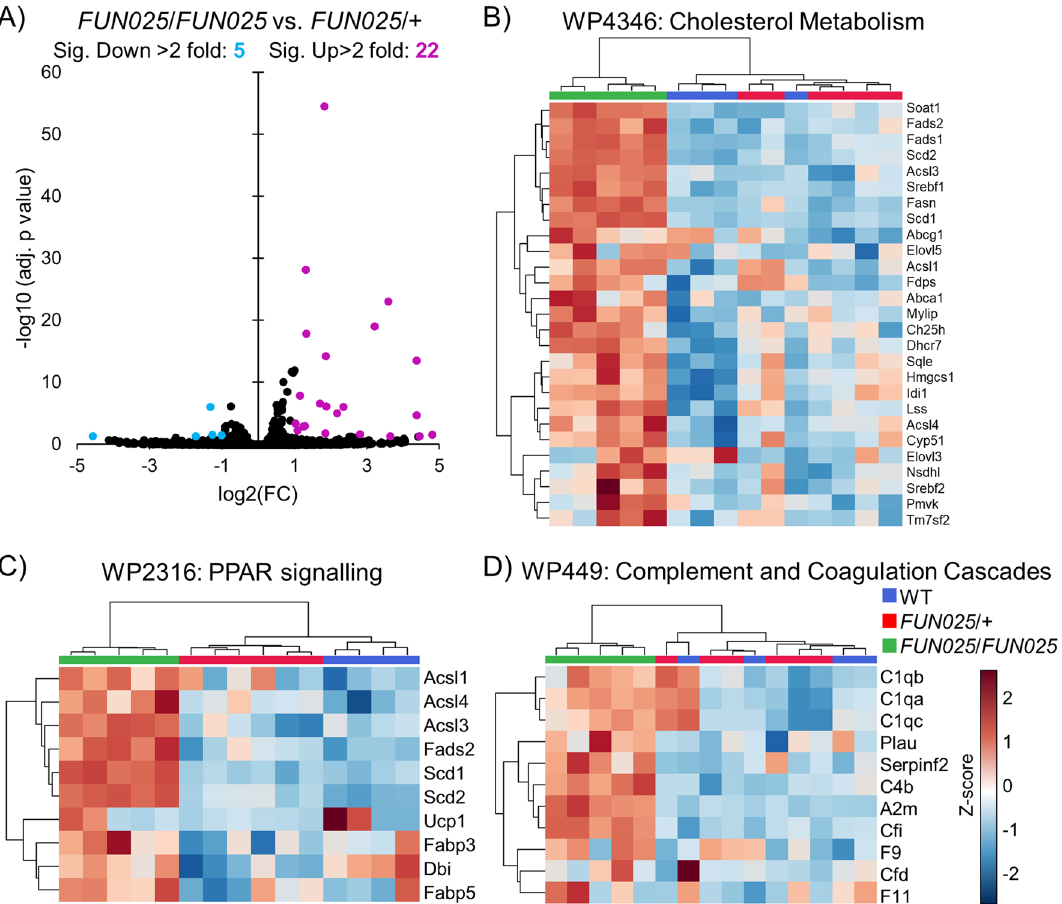
Figure 3. RNA-Seq analysis of 2.5-month-old homozygous Tmem135 mutant eyecups compared to heterozygous Tmem135 mutant eyecups. ( A ) Volcano plot highlighting differentially-expressed genes with fold changes greater than 2 that reach statistical significance ( p < 0.05) between Tmem135 FUN025/FUN025 ( FUN025/ FUN025 ) and Tmem135 FUN025/ + ( FUN025 /+) eyecups. Genes that are upregulated and downregulated are highlighted in magenta and cyan, respectively. Heatmaps of differentially-expressed genes in the leading edge with greater than log2 fold changes between Tmem135 FUN025/FUN025 and Tmem135 FUN025/ + eyecups involved in ( B ) cholesterol metabolism, ( C ) PPAR signalling, and ( D ) complement and coagulation cascades which were identified using gene set enrichment analysis. These genes were unchanged between Tmem135 FUN025/ + and WT